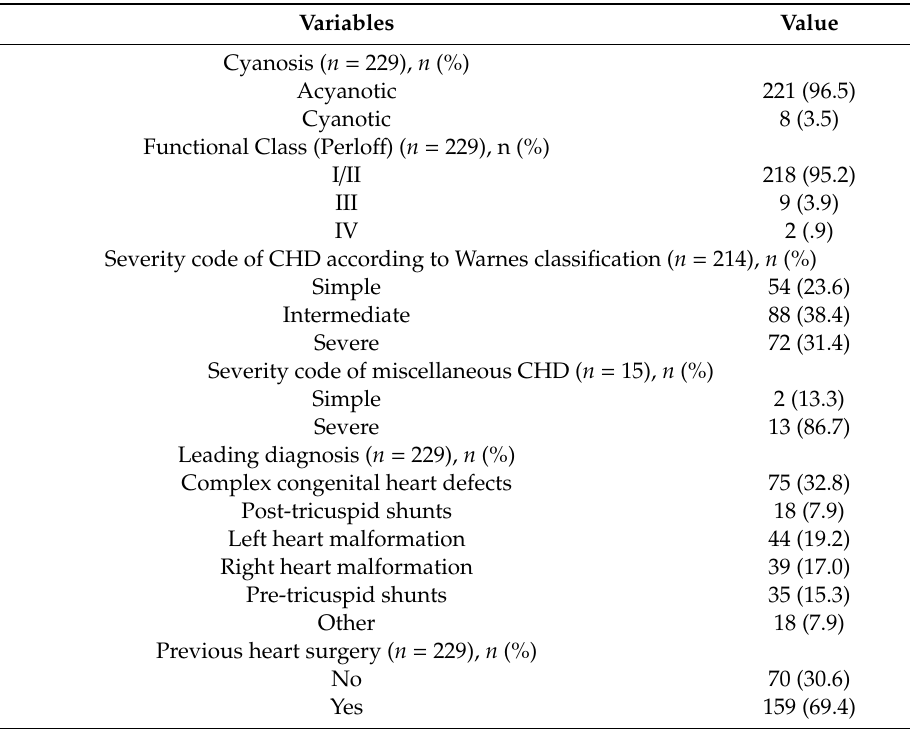
Table 2. Clinical Classification.